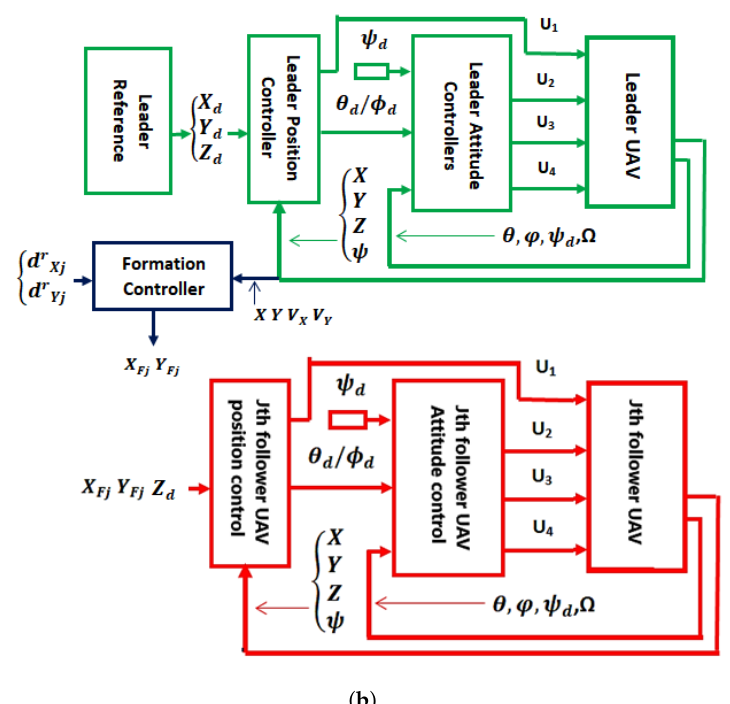
Figure 2. ( a ) Leader-Follower Configuration ( b ) Block